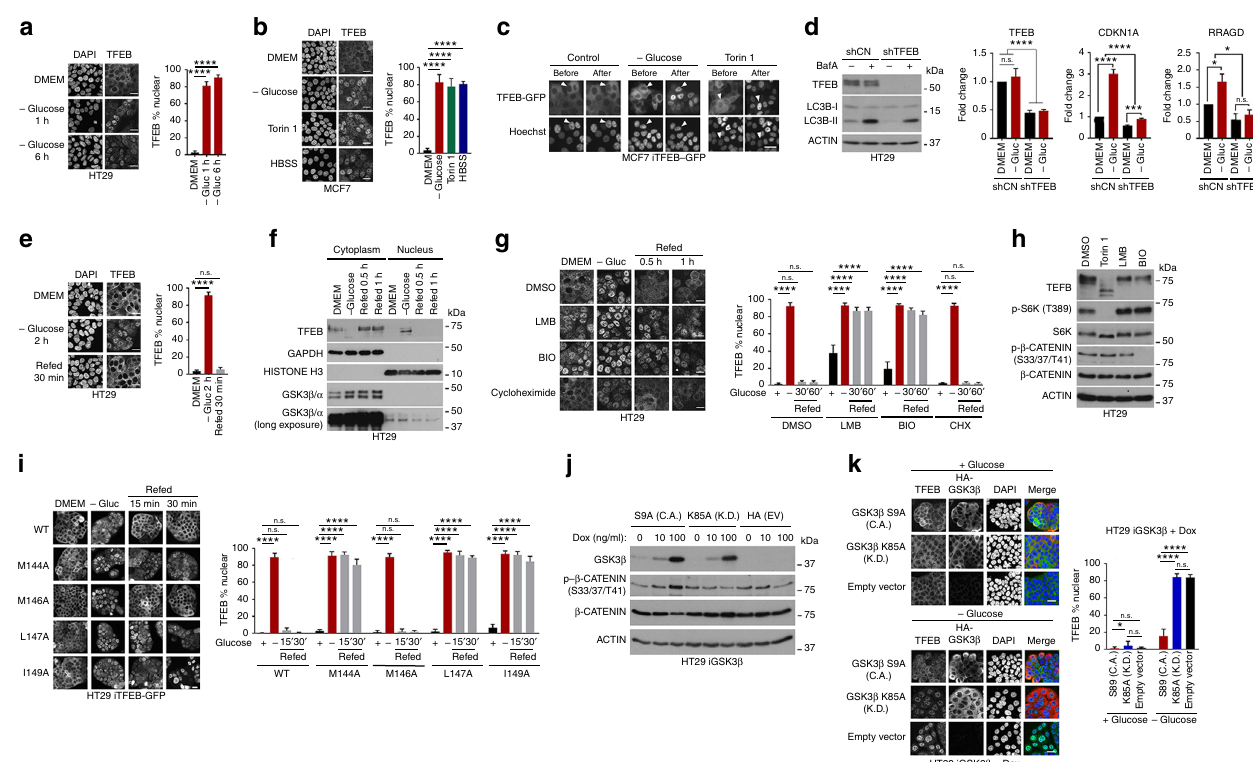
Fig. 6 TFEB nuclear export is regulated by Glucose. a Immuno fl uorescence of HT29 cells grown under indicated conditions. n > 100 cells per condition. b Immuno fl uorescence of MCF7 cells grown in DMEM, minus glucose, or + Torin 1 (250 nM) or HBSS. n > 30 cells per condition. c Live cell imaging of MCF7 iTFEB-GFP cells before or after glucose deprivation or Torin 1 (250 nM) treatment. d Left: western blot of HT29 cells expressing control shRNA or shTFEB grown in the presence or absence of Ba fi lomycin A (10 μ M). Right: real time qRT PCR of CDKN1A (p21) and RRAGD mRNAs from shControl or shTFEB cells grown with or without glucose (3 h) with or without shTFEB. n = 3 individual experiments. Error bars = SD. Two-way ANOVA, * P < 0.05, *** P < 0.001, **** P < 0.0001, n.s. not signi fi cant. e Immuno fl uorescence of HT29 cells grown under indicated conditions. n > 100 cells per condition. f Western blot of fractionated HT29 cells grown under indicated conditions. g Immuno fl uorescence of HT29 cells grown in DMEM, or starved of glucose 1 h before refeeding with glucose alone or with LMB (20 nM), BIO (10 μ M) or cycloheximide (50 μ g ml − 1 ). n > 500 cells per condition. h Western blot of HT29 cells treated with Toirn 1 (250 nM), LMB (2 nM) or BIO (10 μ M) as indicated. i Fluorescence assay of TFEB-GFP WT and indicated mutants stable expressed in HT29 cells. Cells were grown in DMEM, starved of glucose for 2 h, then refed with glucose for 15 or 30 min and fi xed before imaging. j Western blot of HT29 cells stably expressing doxycycline-inducible kinase dead (K.D.) or constitutively active (C.A.) HA-GSK3 β and induced with 0, 10 and 100 ng ml − 1 doxycycline for 20 h. k Immuno fl uorescence using anti-TFEB or anti-HA antibodies of HT29 cells expressing doxycycline-inducible constitutively active (C.A) or kinase dead (K.D.) GSK3 β or empty vector grown in the presence of doxycycline (100 ng ml − 1 ; 20 h) in the presence of glucose or deprived of glucose for 1 h. n > 200 cells per condition. Scale bars = 20 μ M. Error bars = SD. Student ’ s t -test; * P < 0.05, ** P < 0.01, *** P < 0.001, **** P <